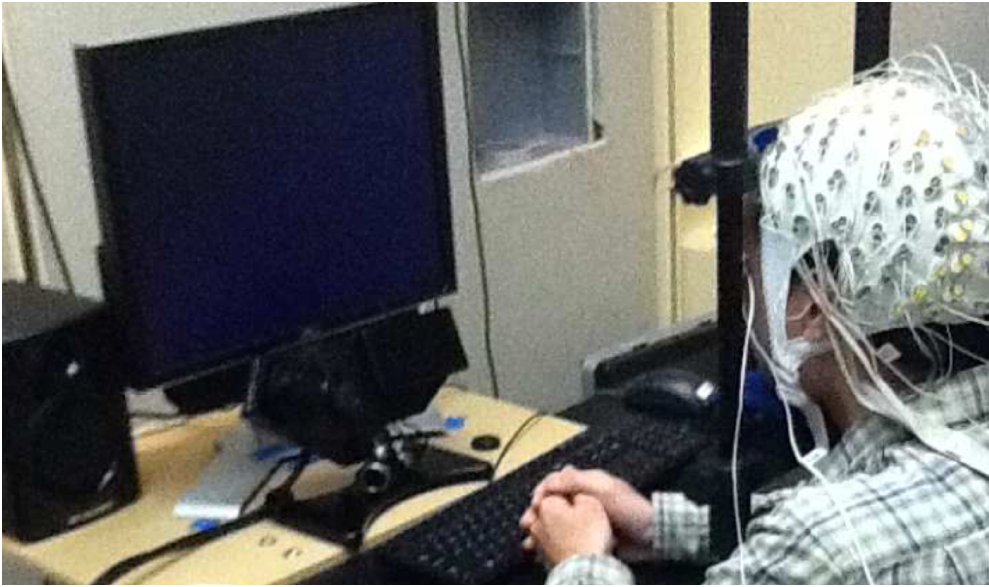
Figure 1. Subject with his head resting on a chin rest where eye gaze data was recorded by a desktop eye tracker ( c (cid:13) 2012 IEEE. Reprinted with permission